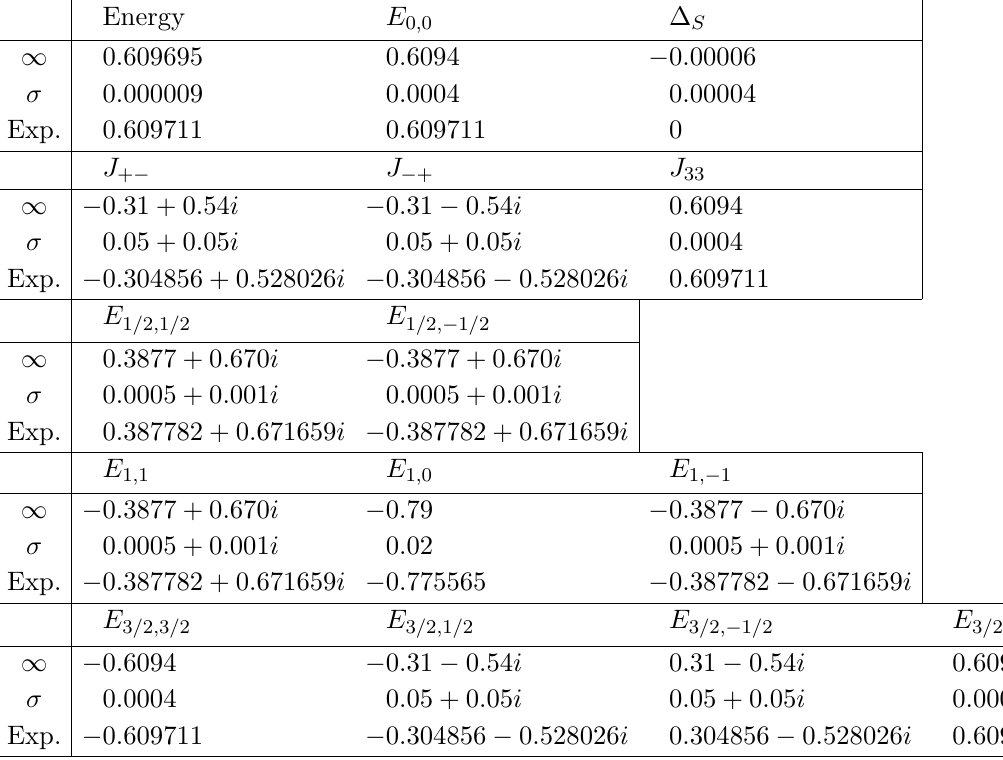
Table 5 . Extrapolations of gauge invariants of a solution describing 0-brane with θ = π/ 3 in the boundary k = 3 model with J = 1 2